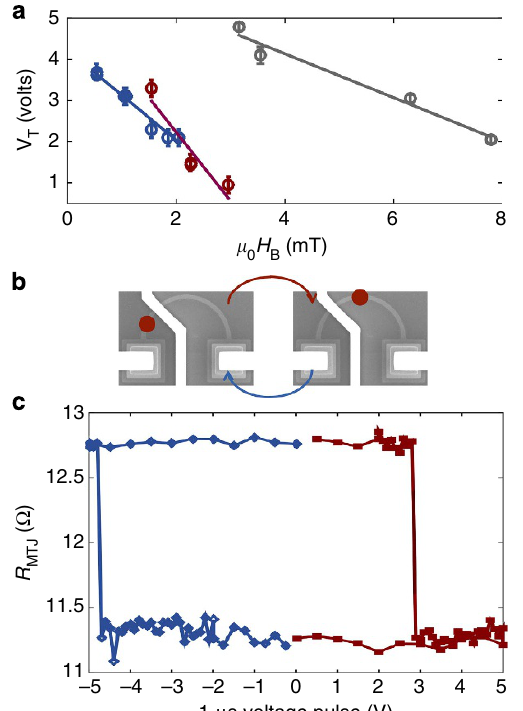
Figure 3 | Variability and reversibility. ( a ) Threshold voltage versus bias field for three different devices, where the error bars represent the depinning voltage standard deviation repeated at least 3 (cid:2) , with the DW reinitialized between each. Grey ¼ device 1, red ¼ device 2 and blue ¼ device 3. The lines are a linear fit. Devices 2 and 3 were fabricated together, while device 1 was fabricated at a later time on a different wafer piece. ( b ) SEM images showing reversibility setup, with the DW moving back and forth past the MTJ as shown by the red dots. ( c ) R MTJ versus pulsed V showing reversibility of device 1’s state. In the positive direction m 0 H B ¼ 3.3mT; in the negative direction m 0 H B ¼ (cid:3) 6.2mT. The red dot in the SEM images is the approximate DW position at high and low R MTJ , respectively.